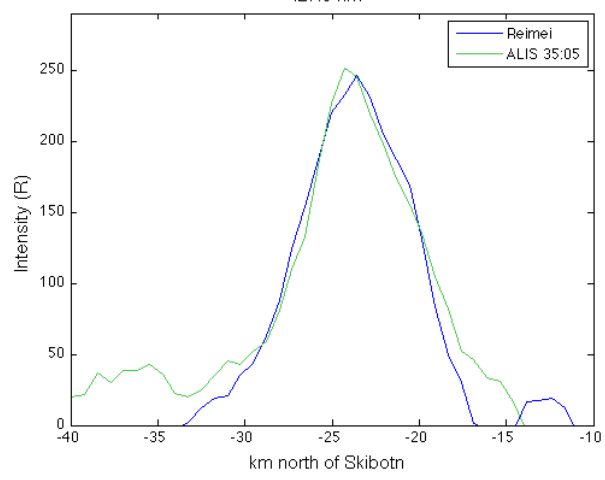
Figure 4. Intensity of the arc measured by ALIS and MAC after removing the background